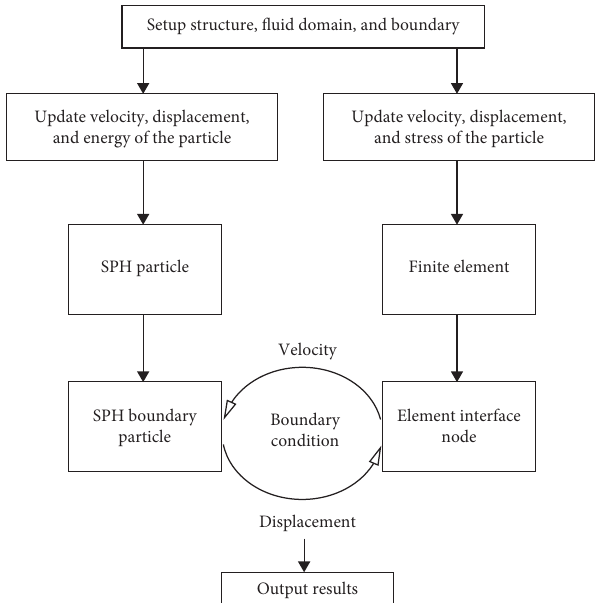
Figure 1: Computation flowchart of the SPH-FEM coupling